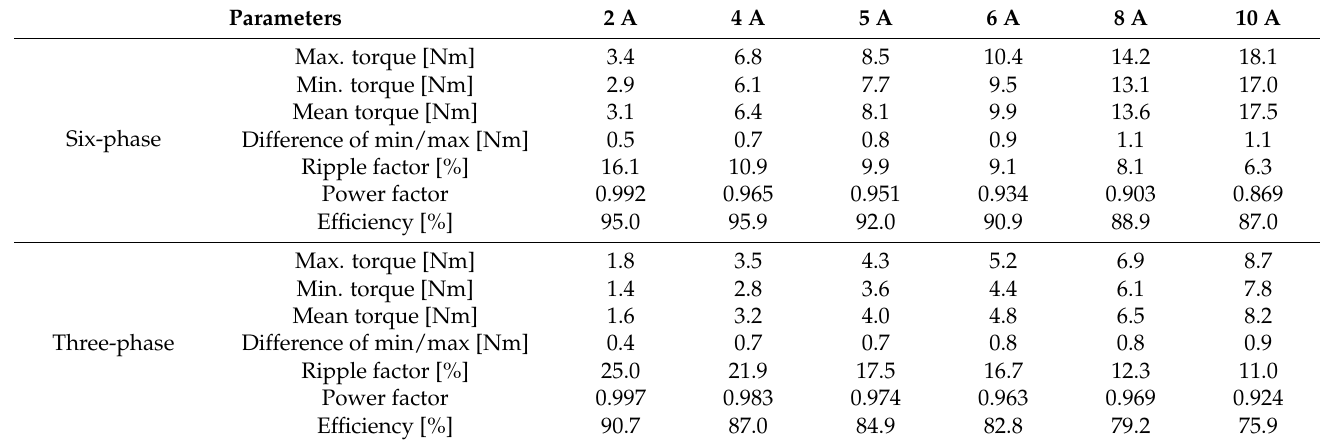
Table 6. Torque characteristic according to currents in FEM at 480 r/min.